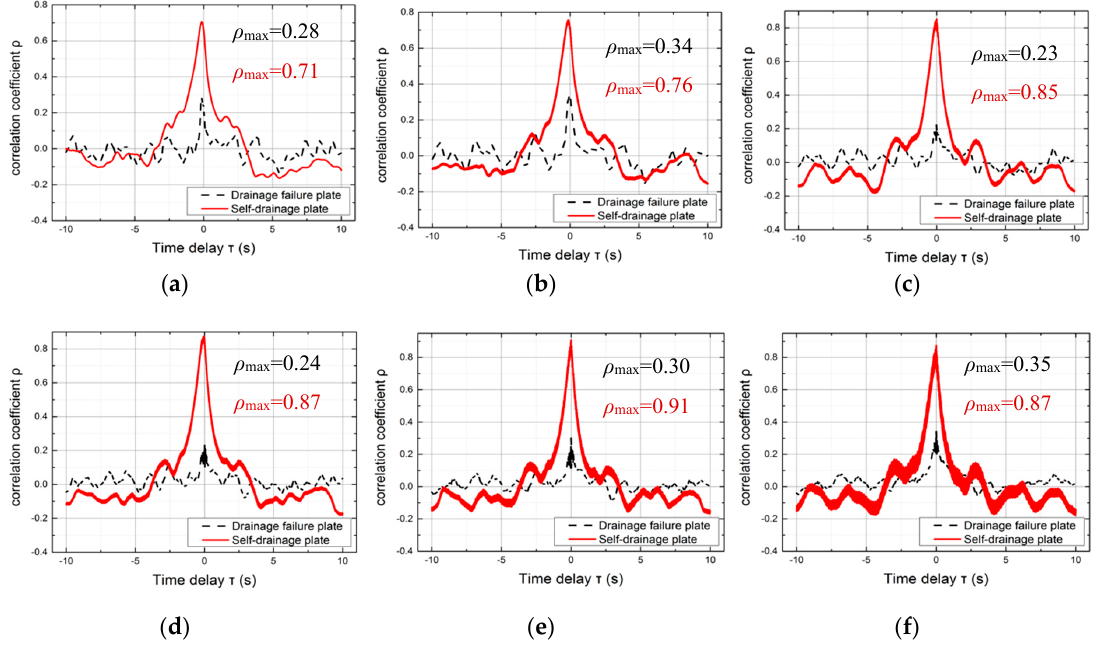
Figure 19. Comparison of the correlations between hydraulic pressure histories measured at the test point pairs on different elevations for the drainage failure and self-drainage plates. ( a ) Test point pair a , b ; ( b ) Test point pair c , d ; ( c ) Test point pair e , f ; ( d ) Test point pair g , h ; ( e ) Test point pair i , j ; and ( f ) Test point pair k , l .